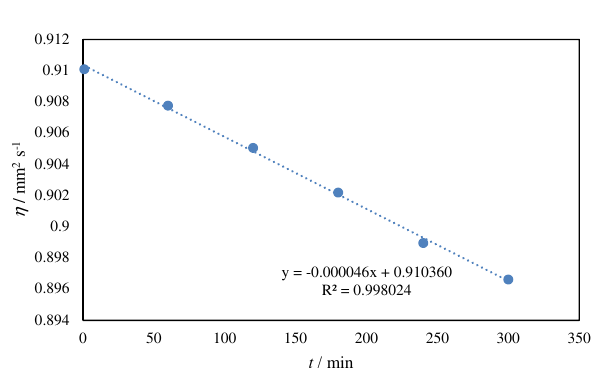
Figure 3. Variation of kinetics viscosity of the nanofluid 0.005 mol kg −1 TiO 2 in aqueous 0.004 mol kg 1 [MOIM][Br] at different time intervals after the dispersion at 25